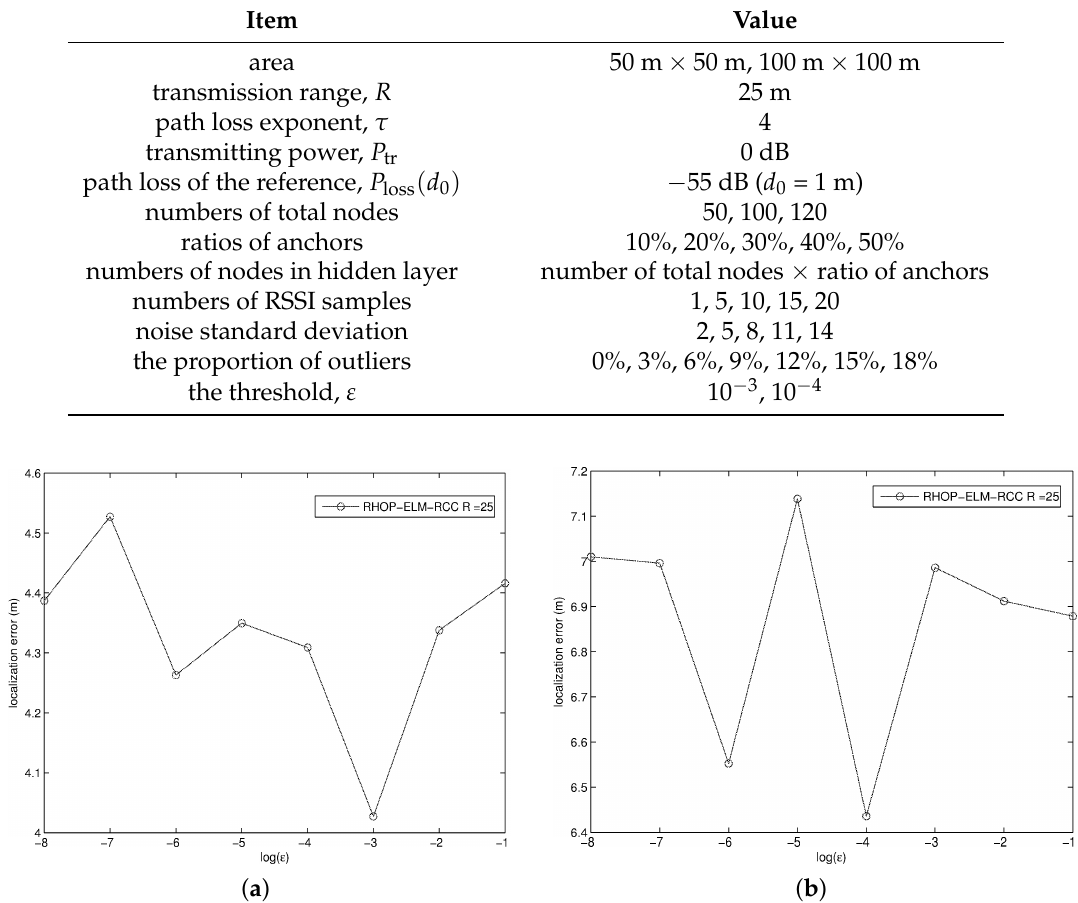
Table 1. Simulation parameters.